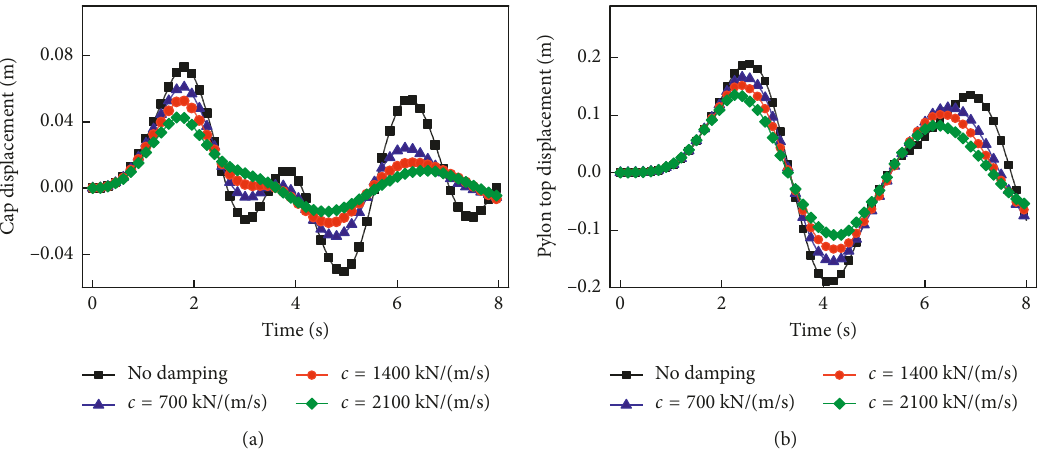
Figure 10: Pile responses in different rows at y M x in 1 st and 5 th rows.